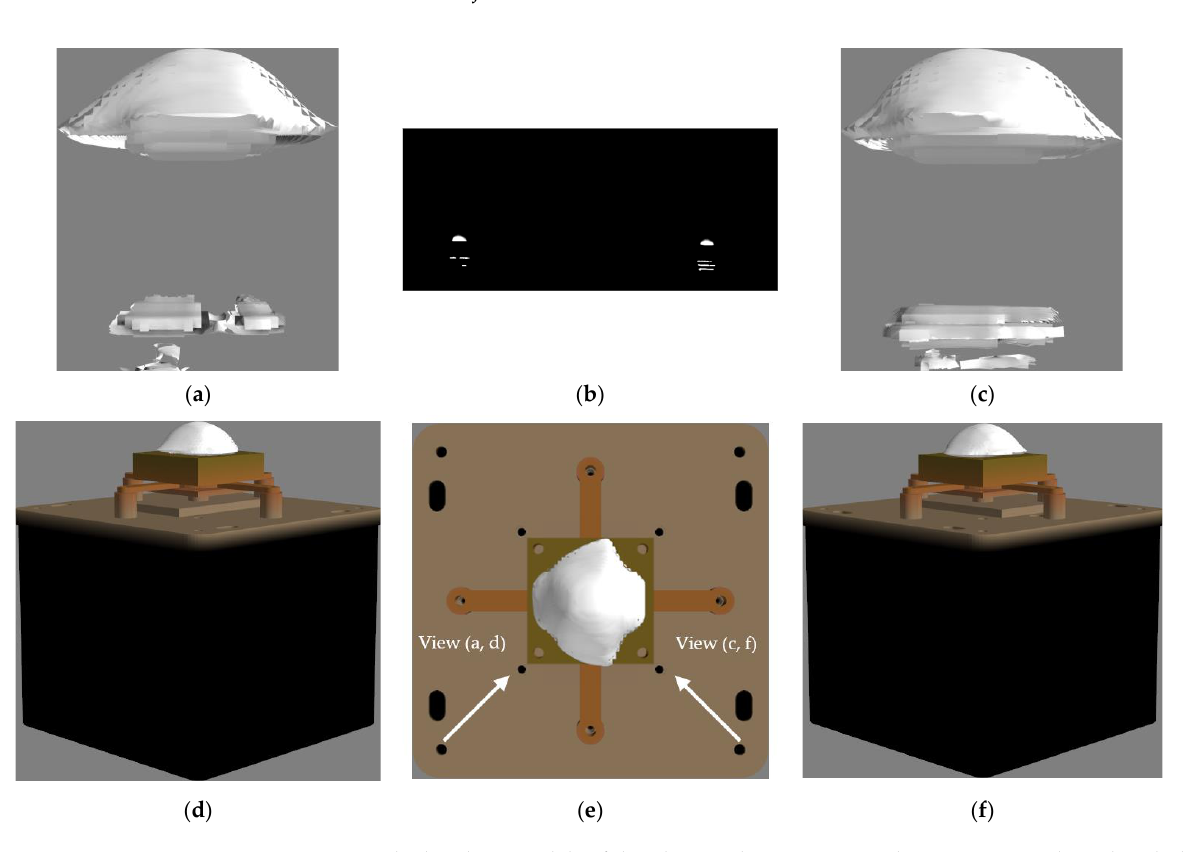
Figure 13. Calculated 3D models of the plasma plume at 1 µs with magnetic nozzle and with the PJP model: ( a ) reconstructed plume left direction of observation; ( b ) recorded image with both directions of observation; ( c ) reconstructed plume right direction of observation; ( d ) isometric view of left direction of observation with PJP; ( e ) front view with PJP; ( f ) isometric view of right direction of observation with PJP.